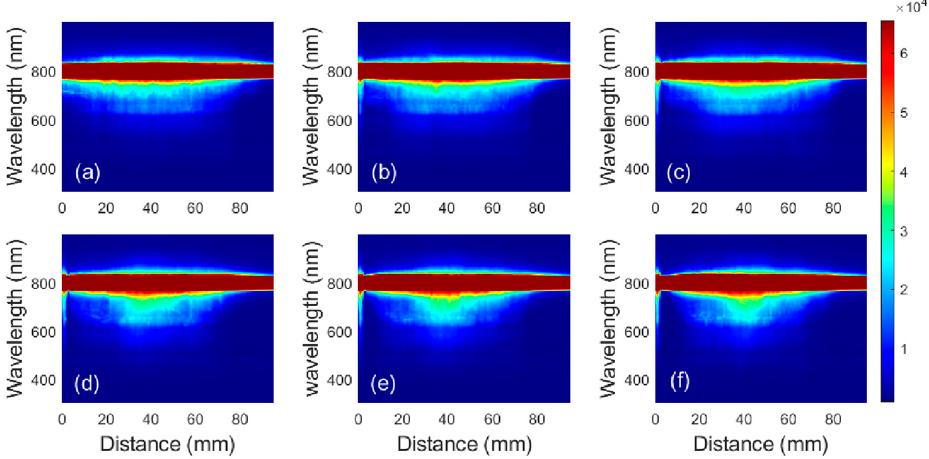
Figure 7. Variation of the SC induced by the filamentation of BG beams with D when the value of TC is ( a ) 0, ( b ) 1, ( c ) 2, ( d ) 3, ( e ) 4 and ( f ) 5. The incident pulse energy is 188 μ J.